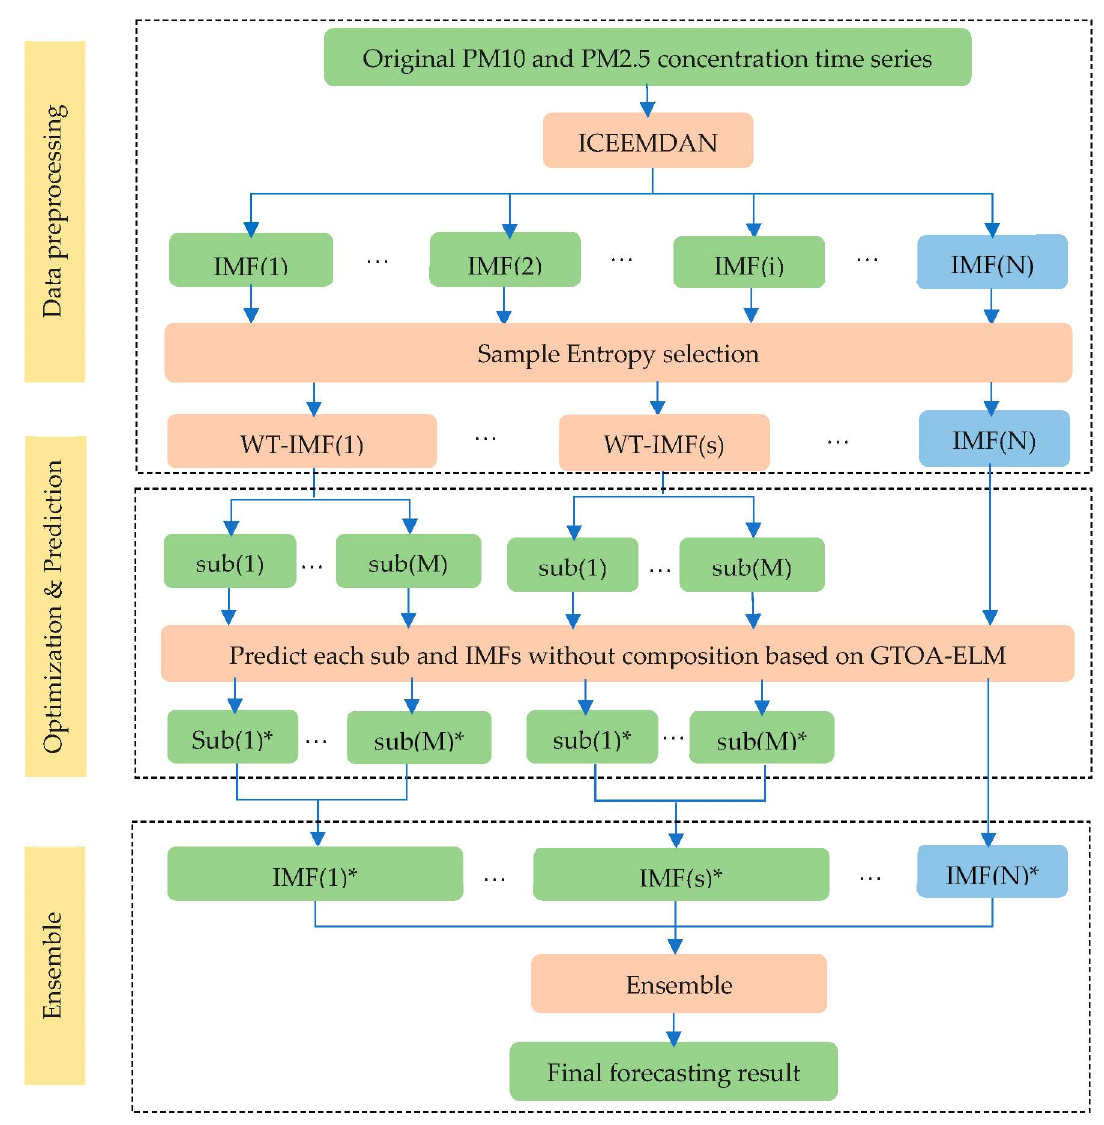
Figure 1. The structure of the proposed improvement complementary ensemble empirical mode decomposition with adaptive noise (ICEEMDAN)-wavelet transform (WT)-group teaching optimization algorithm (GTOA)-extreme learning machine (ELM) hybrid approach. For i = 1,...,N, IMF( i ) is the sub-sequence of the data PM10 and Pm2.5 decomposed by